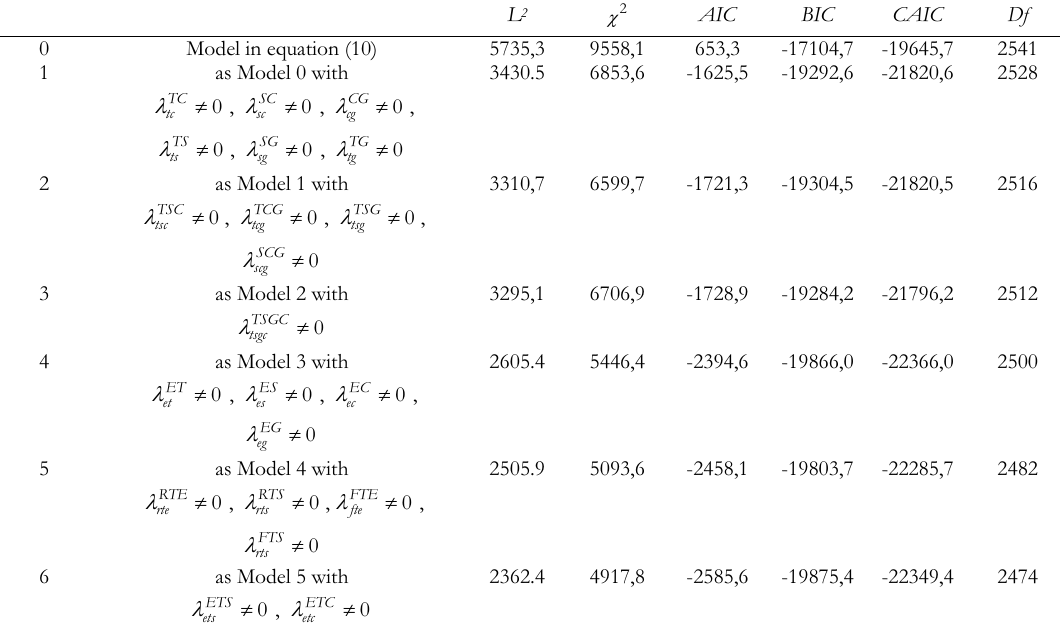
Latent class analysis evaluation criteria for 2002 shiw